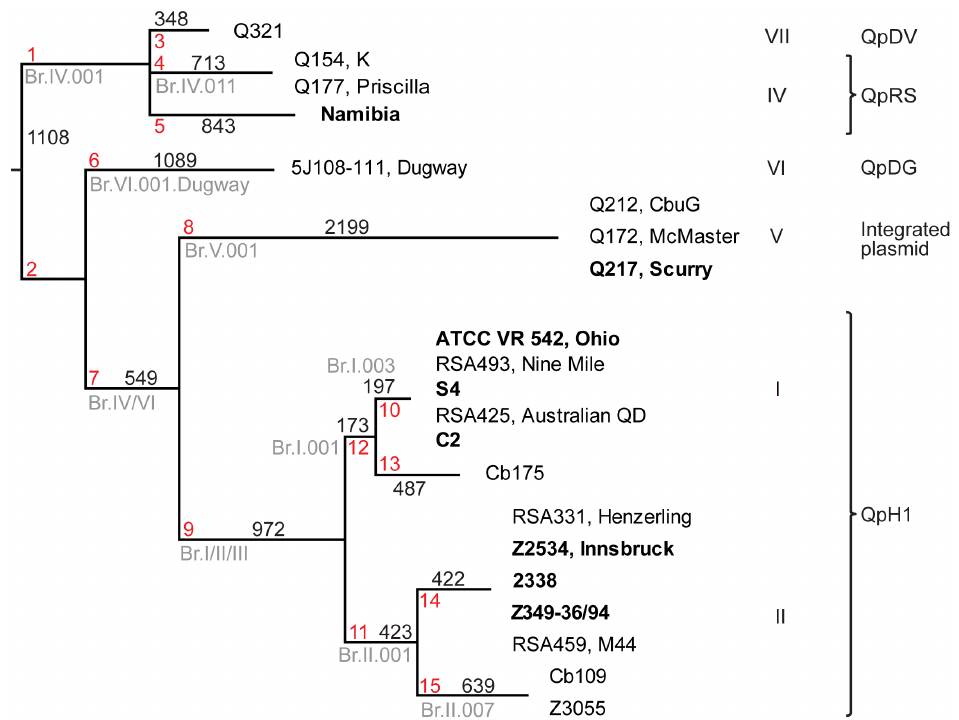
Figure 1. Phylogenetic tree. Branch lengths are proportional to the total number of SNPs, which are indicated above or below the branches. Genomes sequenced in this study are in bold face. The genomic groups (I–VII) and plasmid types are denoted as described [21,26,28]. CanSNP markers are depicted in red (C.1–C.15) and the corresponding MST markers are depicted in grey. The genomes Cb109, Cb175 and Z3055 became available after the time of assay design resulting in four new branches (C.12 to C.15). Although not included in this work, it demonstrates that the systematics of canSNPs easily can be extended when new genomes become available. The ancestral and derived state for C.1 and C.2 could not be determined due to the lack of sequence from a near neighbor (a root). Therefore, we could only design one assay C.1 that could be on either the C.1 or C.2 branches.